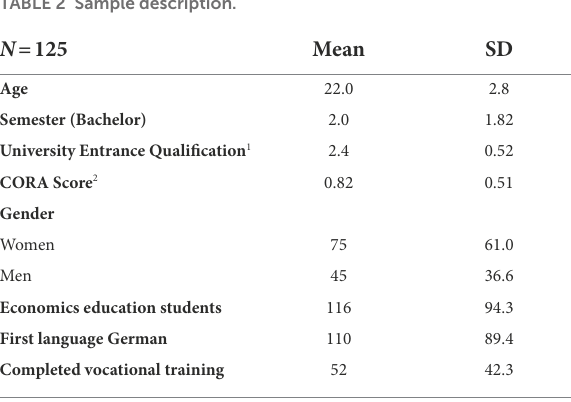
TABLE 2 Sample description.